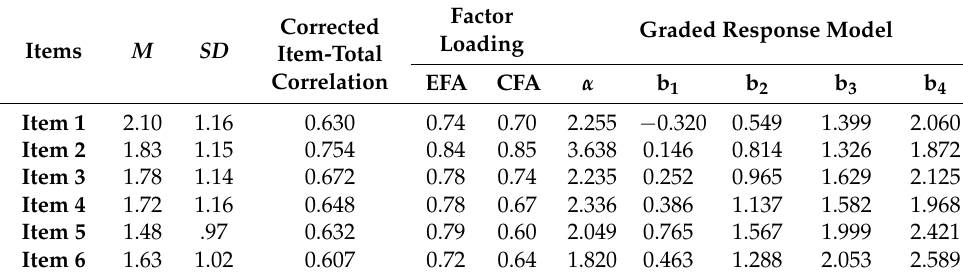
Table 2. Item-level psychometric properties of the Problematic QQ Use Scale.